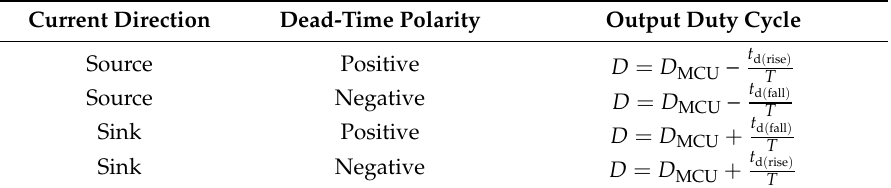
Table 1. Output duty cycle in CCM.